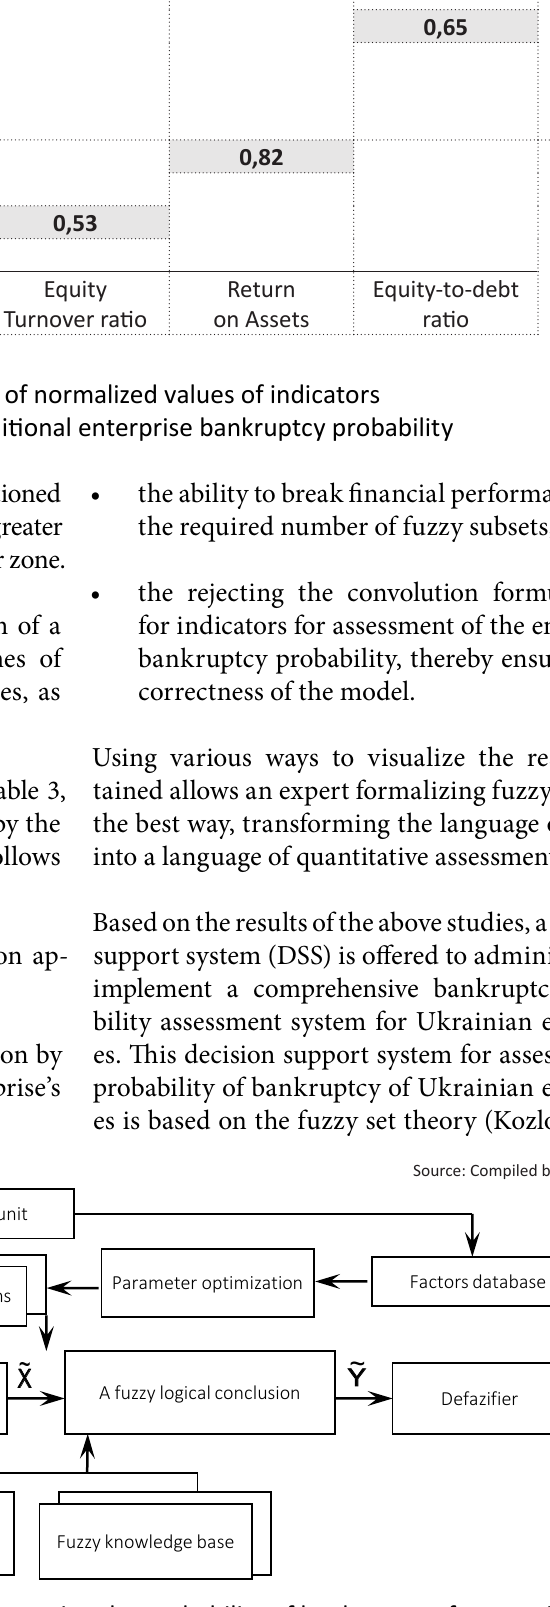
Figure 2. Decision support system for assessing the probability of bankruptcy of